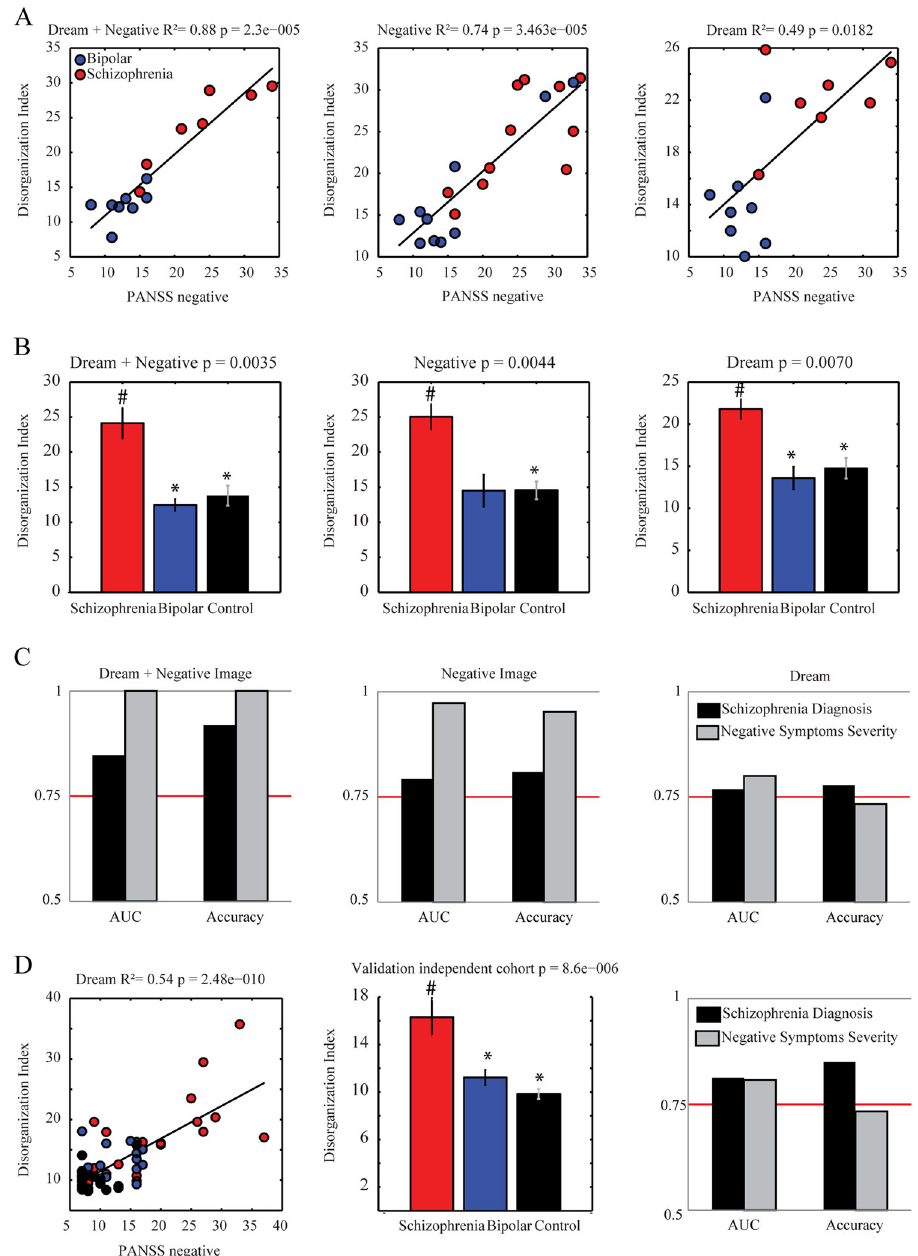
Fig. 4 Disorganization Index classi fi es negative symptoms severity and schizophrenia diagnosis 6 months in advance. a Multiple linear correlation between PANSS negative subscale vs. Disorganization Index from dream + negative image reports, from negative image reports, or from dream reports ( R 2 and p value indicated on title; linear coef fi cients used to calculate Disorganization Index on Results). b Bar plot of the mean and standard error of Disorganization Index from dream + negative image reports, from negative image reports, or from dream reports for diagnostic groups (schizophrenia in red , bipolar in blue and control in black ; bar plots indicate of median values and error bars indicate s.e. m; Kruskal – Wallis tests (Bonferroni corrected for 6 comparisons (2 memory reports asterisk 3 groups)): p value indicated in each title; # indicates p < 0.0063 — Schizophrenia > Bipolar and Control groups; asterisk indicates p < 0.0063 — Schizophrenia > Bipolar or Control groups). c Classi fi cation quality using only Disorganization Index from dream + negative image reports, from negative image reports, or from dream reports (measured by AUC and Accuracy — classi fi cation of schizophrenia diagnosis 6 months in advance ( black ); Negative Symptom Severity measured by PANSS negative subscale ( gray ). d Validation of the Disorganization Index using dream reports from an independent cohort of chronic psychotic patients. 9 Multiple linear correlation between PANSS negative subscale vs. Disorganization Index ( R 2 and p value indicated on title; linear coef fi cients used to calculate Disorganization Index on Results), statistical comparison (schizophrenia in red , bipolar in blue and control in black ; Kruskal – Wallis tests: p value indicated in each title; # indicates p < 0.0063 — Schizophrenia > Bipolar and Control groups; asterisk indicates p < 0.0063 — Schizophrenia > Bipolar or Control groups) or classi fi cation quality (measured by AUC and Acc — classi fi cation of schizophrenia diagnosis 6 months in advance ( black ); Negative Symptom Severity measured by PANSS negative subscale ( gray